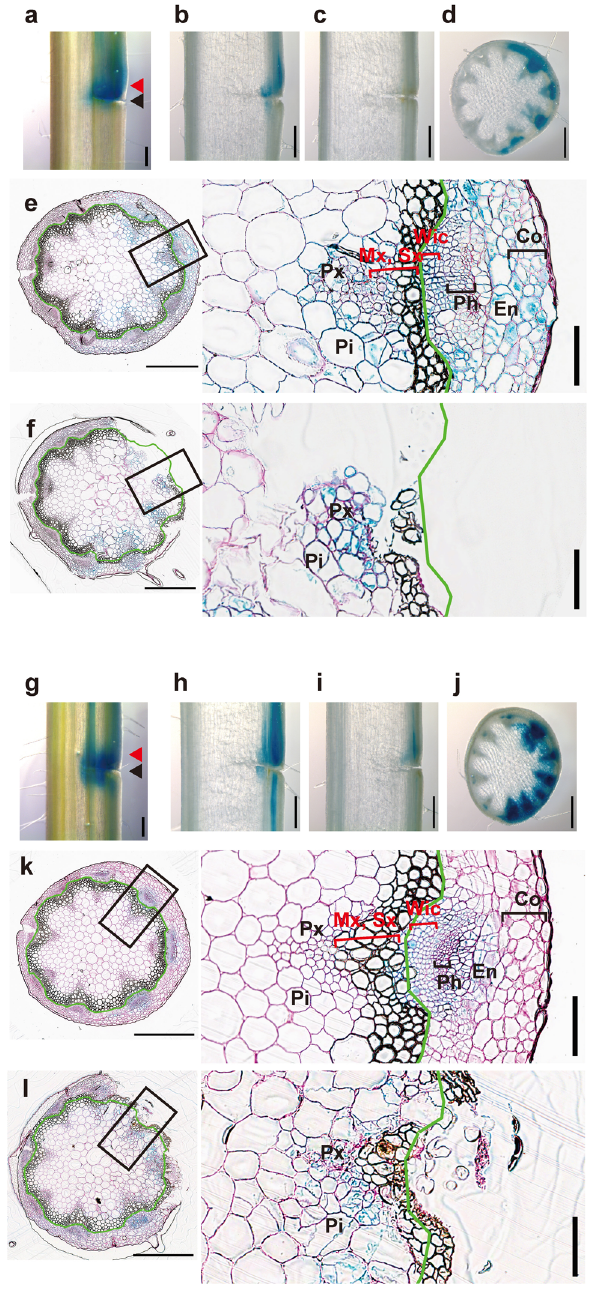
Fig. 3 Tissue localization of ANAC gene expression in incised stems. Histochemical analysis of p ANAC071 ::GUS ( a – f ) and p ANAC096 ::GUS ( g – l ) was performed at 3 DAI. Opposite and incised sides are shown on the left and right, respectively. a , g Incised stems are displayed from the surface. Freehand longisections were prepared from incised stems with ( b , h ) or without ( c , i ) apical buds. d , j Freehand cross-sections from the incision to the upper part. Thin cross-sections were prepared from the upper region of the incision ( e , k ; red arrowheads of a and g ) and the incised region ( f and l ; black arrowheads of a and g ). Scale bars = 500 μ m. Magni fi ed images of the black rectangular area are shown on the right. The green line shows the outline of sclerenchyma tissue. Pi pith, Px protoxylem, Mx metaxylem, Sx secondary xylem, Wic wound-induced cambium, Ph phloem, En endodermis, Co cortex. Cell walls with red color were counterstained by periodic acid-Schiff. Scale bars = 100 μ